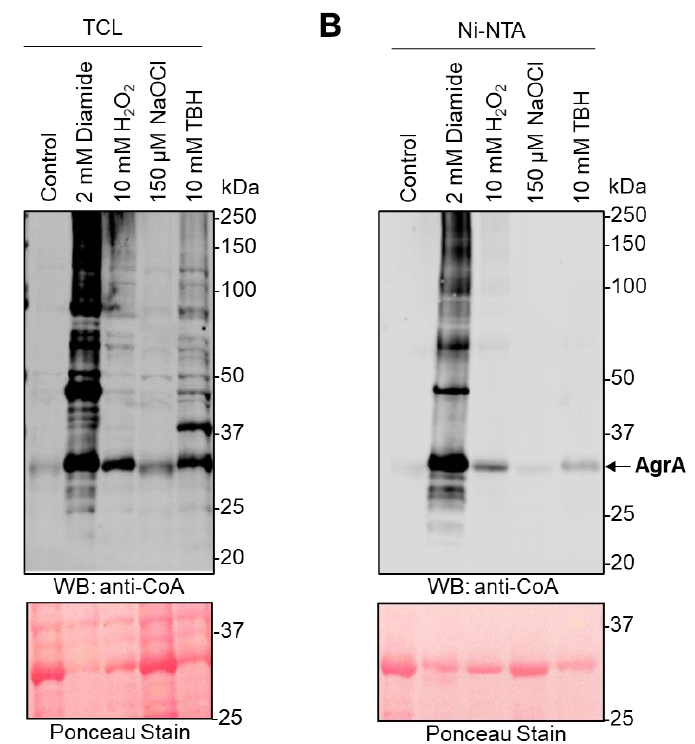
Figure 2. Sa AgrA CoAlation is induced by treatment with oxidizing agents. The expression of Sa AgrA in E. coli transformed with the pET28/His- Sa AgrA plasmid was induced with 0.1 mM IPTG for 20 min at 37 °C. Bacterial cultures were then treated with 2 mM diamide, 10 mM H 2 O 2 , 100 µM NaOCl, or10 mM TBH for 30 min. Harvested cell lysates were incubated with Ni-NTA Sepharose beads and Sa AgrA was pulled down. The total cell lysates (TCL) ( A ) and pulled down Sa AgrA ( B ) were analyzed by anti-CoA Western blots. The Ponceau stains served as loading control. The figures are representative of at least three independent repeats.